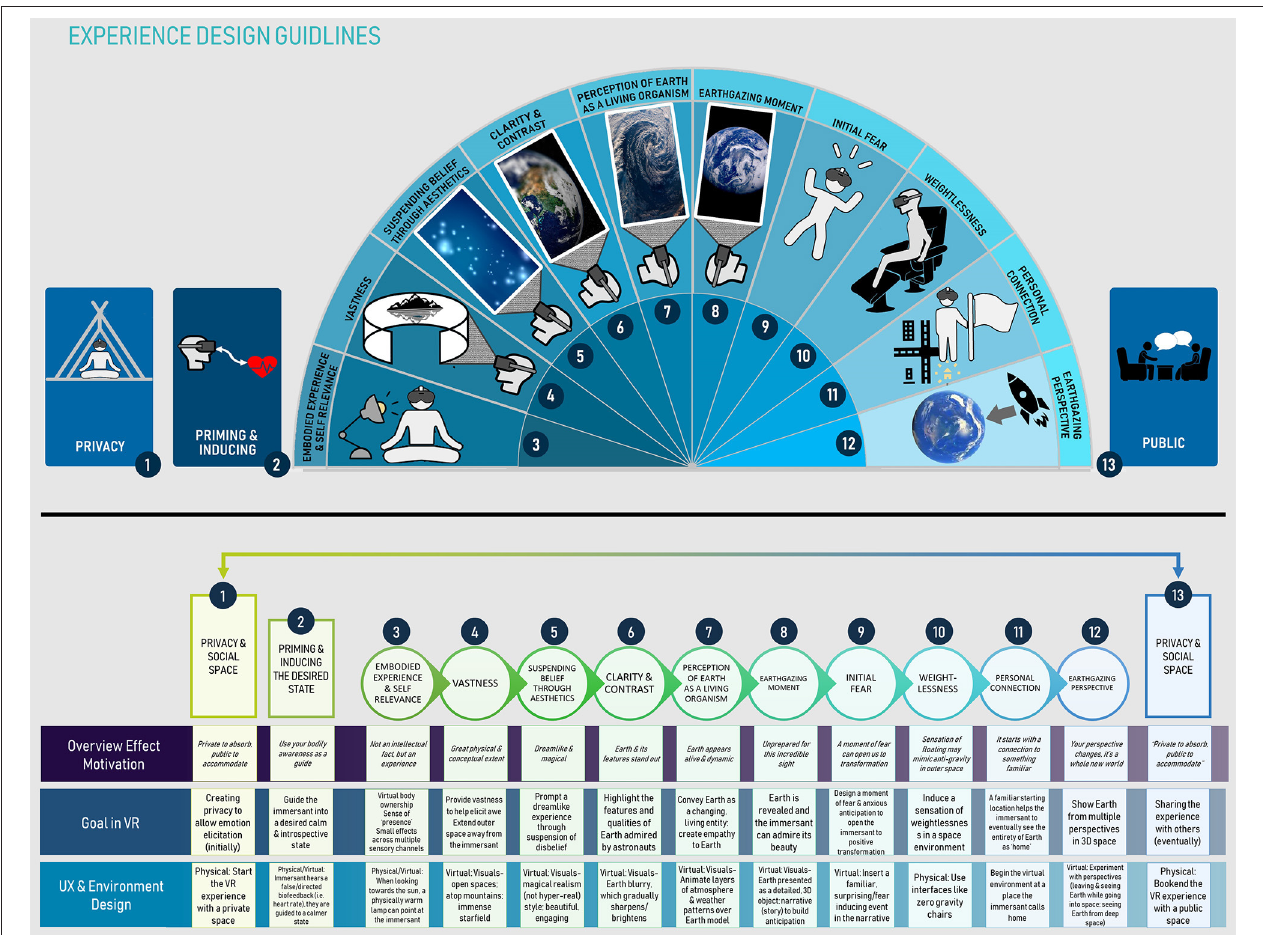
FIGURE 2 | Experience Design Guidelines summarized in a proposed use scenario. Images courtesy of NASA’s public domain image library.